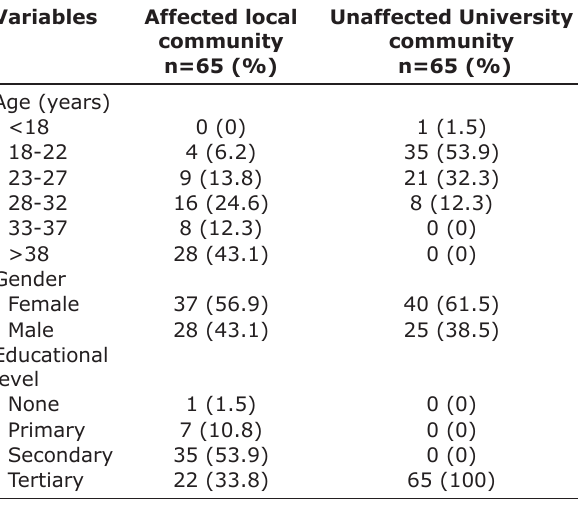
Table-1: Demographic characteristics of respondents in the affected local and unaffected university communities, Ibadan, Nigeria